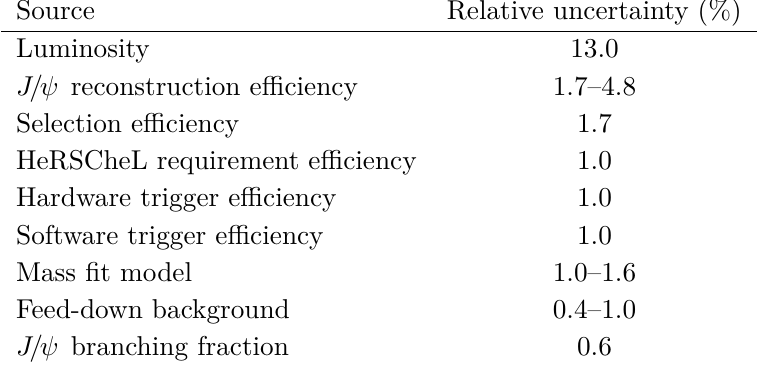
Table 2 . Systematic uncertainties considered for the differential cross-section measurement of coherent J/ψ production, relative to the central value. Uncertainty ranges correspond to variation over the rapidity intervals. The dominant uncertainty arises from the luminosity determination and is correlated over all